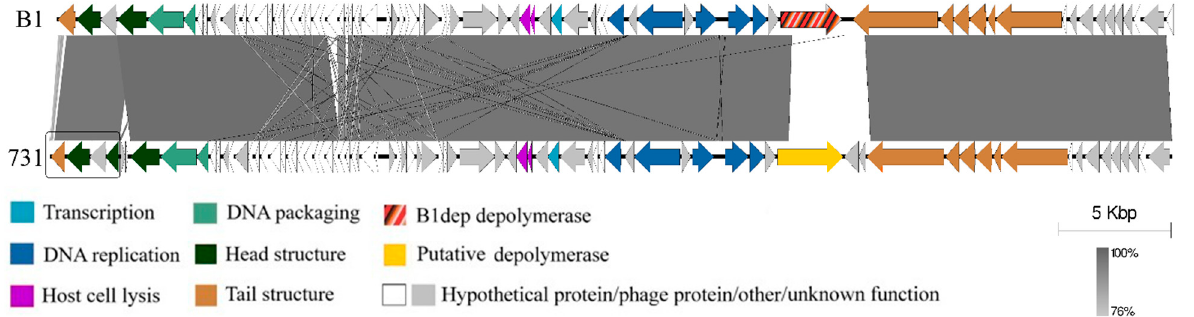
Figure 4. Comparative genome analysis of the previously isolated Klebsiella phage B1 and phage 731. Annotations of the genomes were done by the RAST server and were visualized by Easyfig. Predicted gene function groups are indicated.